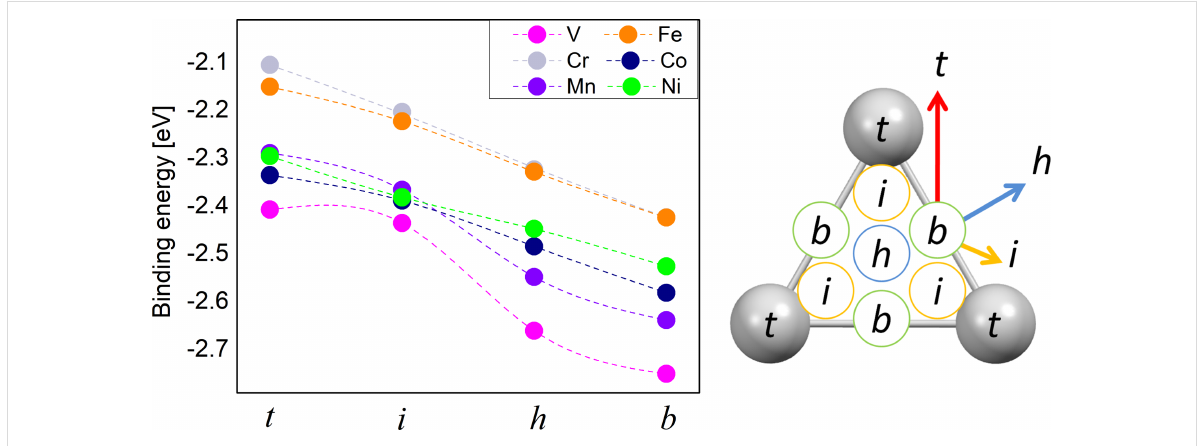
Figure 2: Left: binding energy values, , for all systems and relative molecule–surface positions. Right: symmetry-equivalent positions on the Ag(111) surface, according to our notations. The color arrows indicate qualitatively the jumping probabilities over the energy barriers in the systems (blue = highest, red =